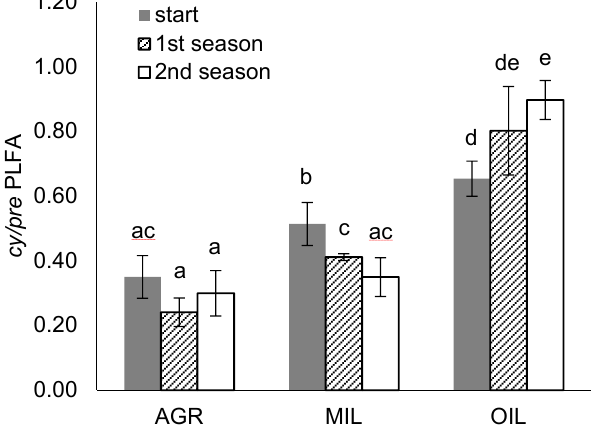
Figure 8. Cy / pre PLFA stress indicators at the beginning and end of the vegetation periods (mean ± SD, n = 4), the same letters above bars mark comparable groups according to Wilcoxon rank-sum test ( p < 0.05)